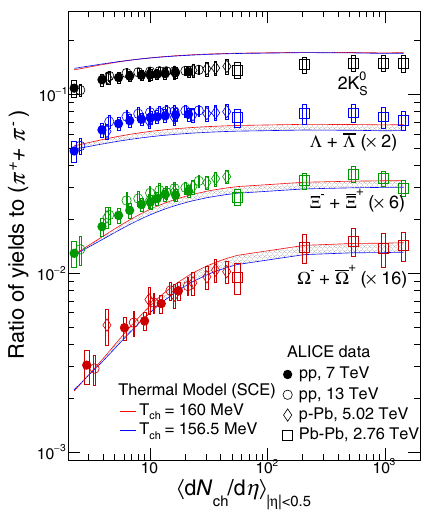
Figure 3. Strange and multi-strange particles to pions yield ratios versus charged particle multiplicity. The symbols show experimental data and the lines represent the SCE model results obtained using V A (cid:31) V C .